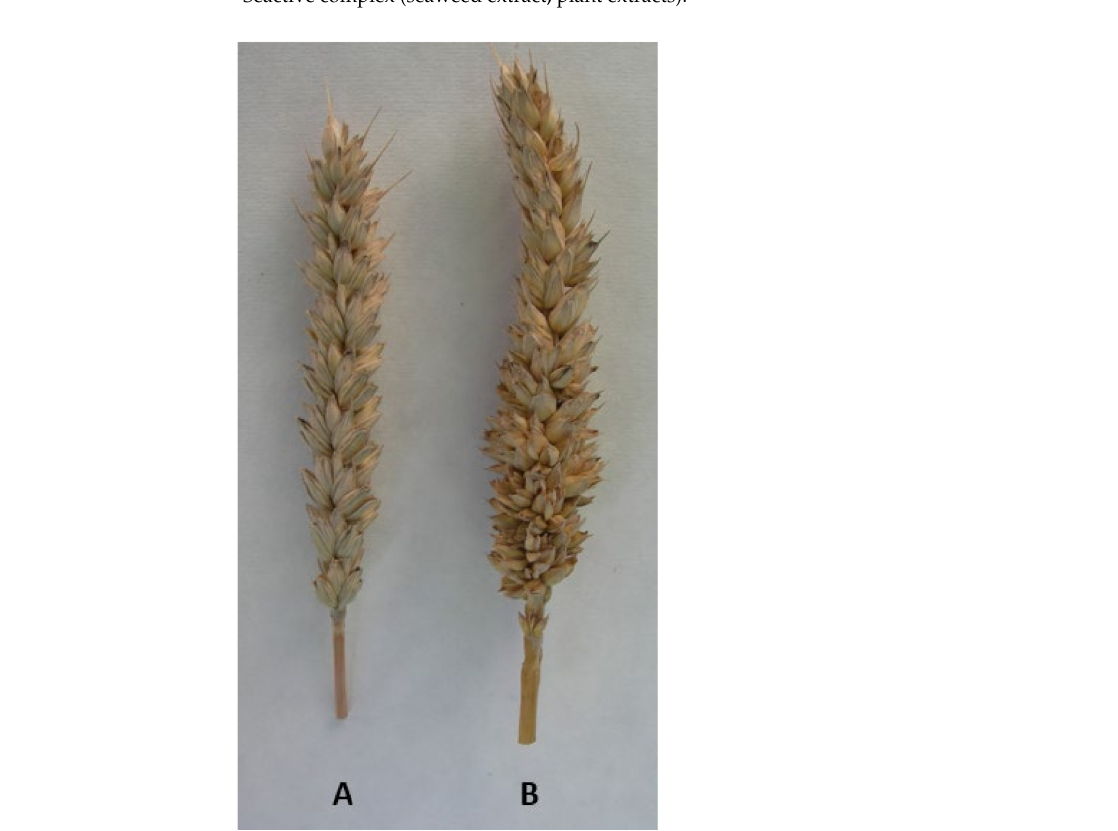
Preparation Characteristics